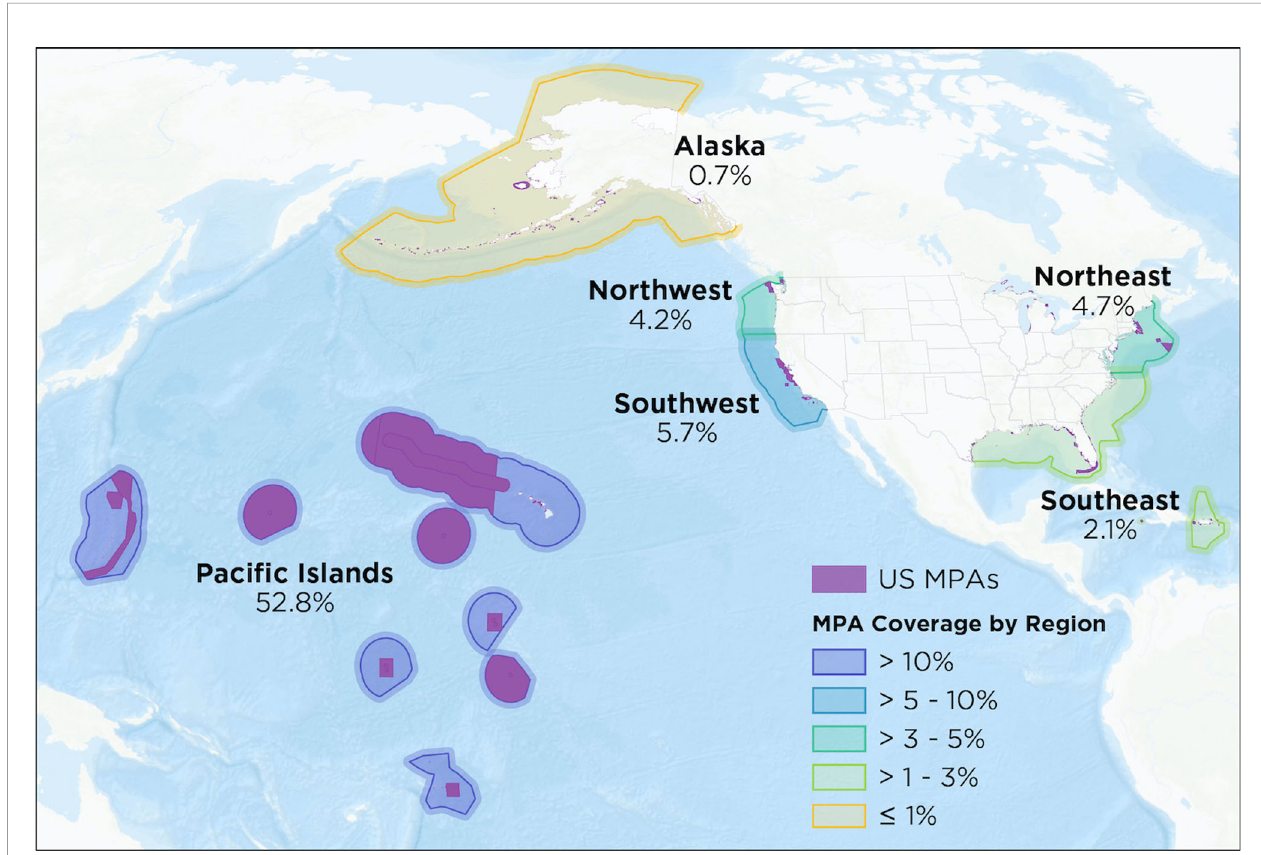
FIGURE 1 | Percent marine area in any kind of implemented MPA by U.S.